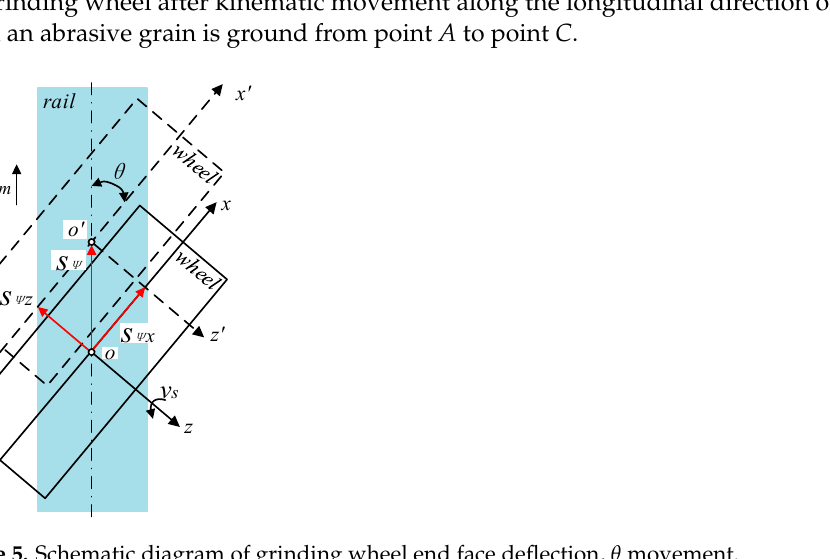
Substitute Equation (2) into Equation (3) and then differentiate to get Equation